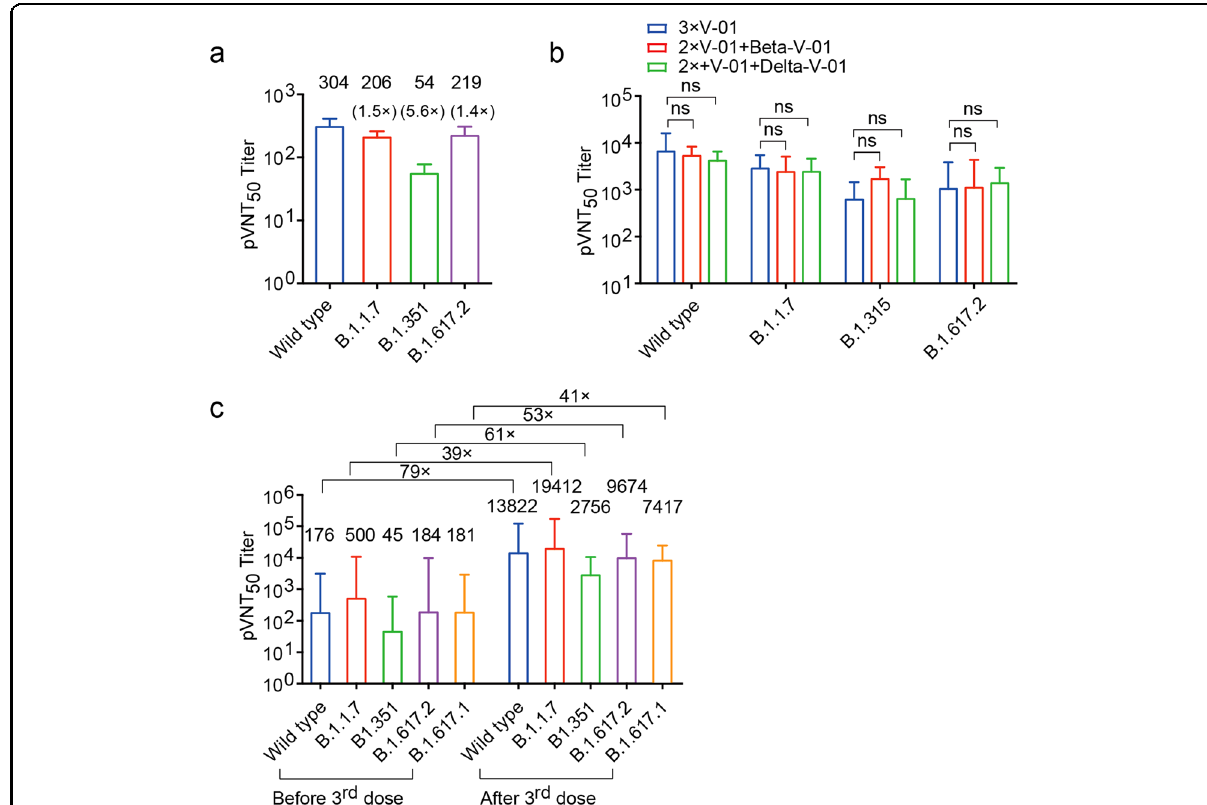
Fig. 1 Analysis for neutralization of variant SARS-CoV-2 by serum samples from the V-01 phase II trial participants and the V-01- vaccinated animals. a Serum samples ( n = 20) were collected from participants in the V-01 vaccine phase II trial on day 49 (28 days post the second dose) immunized with two doses of 10 μ g of V-01. Samples were tested for neutralizing activity against WT SARS-CoV-2, B.1.1.7, B.1.351, and B.1.617.2 variants, using pseudovirus neutralization assays. The geometric mean of neutralizing antibody titer (GMT) is shown at the top of the indicated column, and 95% con fi dence intervals are shown. The GMT fold-reduction over the WT for each variant is indicated. b C57BL/6 mice ( n = 10/group) were intramuscularly vaccinated three times with 2 μ g of V-01 on days 0, 14, 28, or immunized twice with 2 μ g of V-01 and further boosted with the equivalent dose of Beta-V-01 or Delta-V-01 on day 28 after prime immunization, respectively. The serum samples were collected on day 42 after initial vaccination to evaluate the neutralizing antibody titers. The pVNT 50 in serum sample against wild-type SARS-CoV-2, B.1.315, B.1.617.2, and B.1.1.7 variants were analyzed using pseudovirus neutralization assays. c Rhesus macaques were intramuscularly immunized with V-01 via a prime-boost vaccination regimen at a 14-day interval. These macaques were then given a booster dose of V-01 after 300 days of initial vaccination. The serum samples were collected on day 300 post the initial immunization and 21 days after the third dose and subjected to pseudovirus neutralization assays. The pVNT 50 of these sera against WT SARS-CoV-2 and the variants B.1.1.7, B.1.351, B.1.67.2, and B.1.67.1 was analyzed. The GMT fold changes after the third dose vs before the third dose are labeled. Data are shown as GMT and 95% con fi dence intervals. P values were calculated by one-way ANOVA with multiple comparison tests. n.s., not signi fi cant, * P < 0.05, ** P <